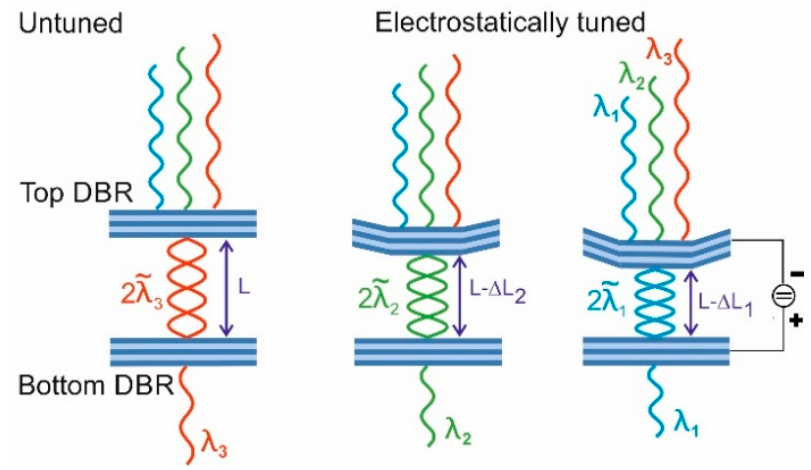
Figure 10. Single air-gap MEMS tunable FP filters with four times half-a-wavelength cavity (4 ∙ λ /2) and semiconductor DBRs.